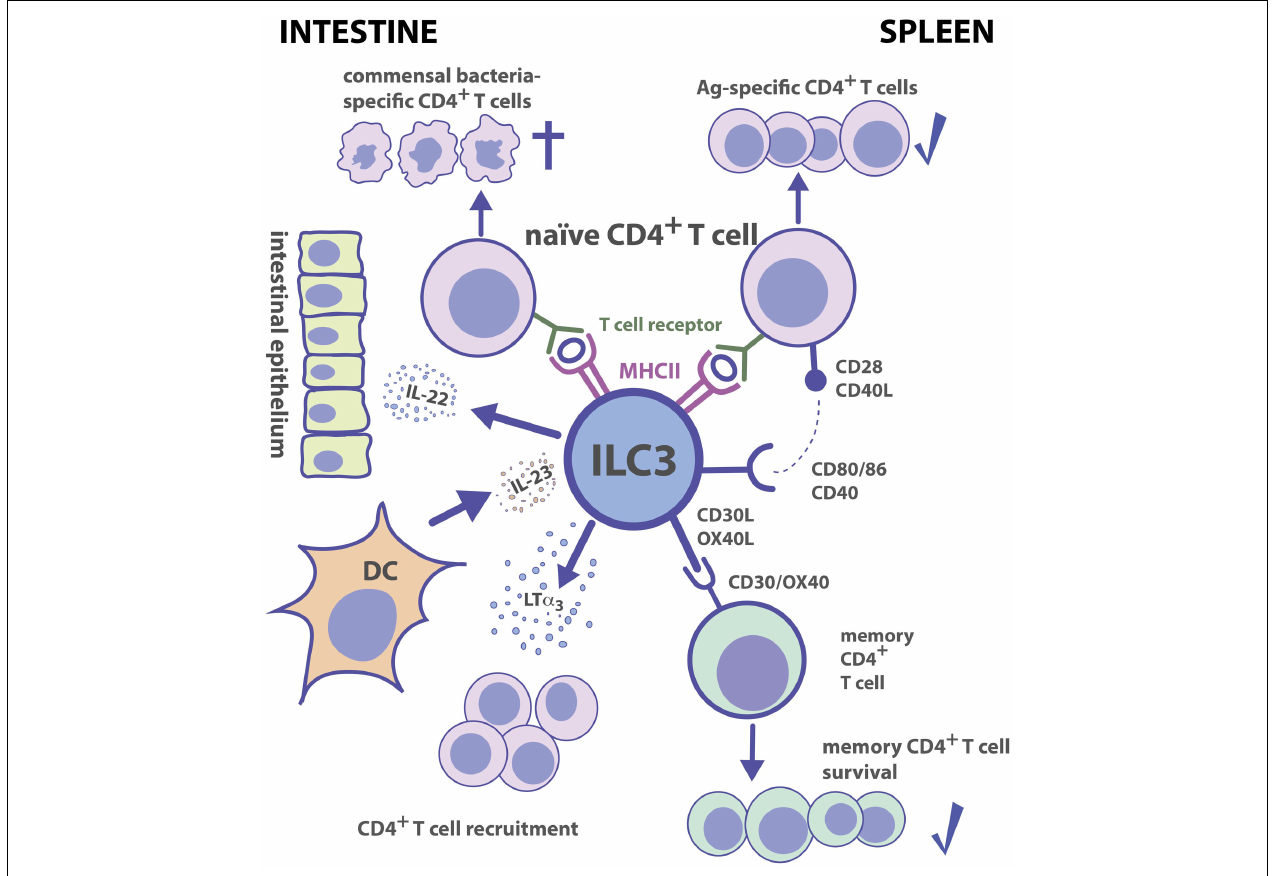
FIGURE 2 | Group 3 ILC–CD4 +++ T cell interactions . Tissue localization greatly affects the outcome of Ag-dependent T cell–ILC3 interaction. Intestinal ILC3s maintain tolerance toward commensal microbiota, while splenic ILC3s are efficient in the induction of Ag-specific CD4 + T cell responses and memory CD4 + T cell